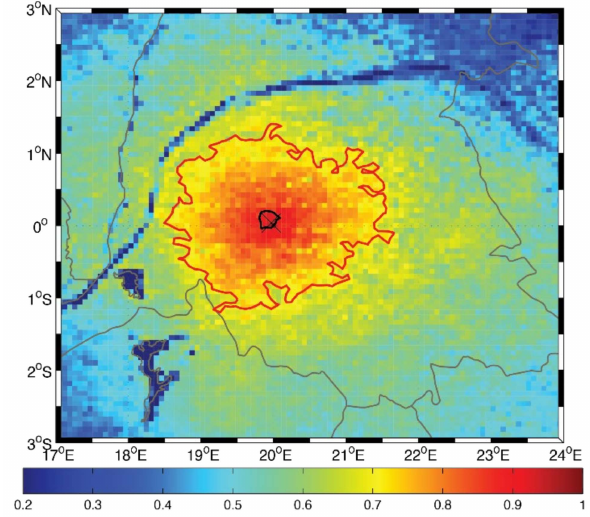
Figure 3. Example calculation of the DCLS value at location (20 ◦ E, 0 ◦ N). The Congo Basin’s boundary can be seen in gray. The background color represents the correlation coefficient matrix, and the black and red contours represent the 0.9 and 0.7 contour levels, respectively. The associated DCLS for the black 0.9 contour level is 16 km, whereas the DCLS for the red 0.7 contour is 140